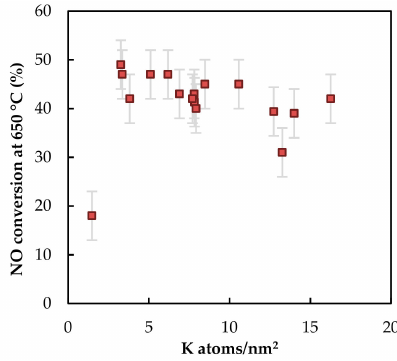
Figure 13. The dependence of NO conversion at 650 ◦ C on normalized potassium